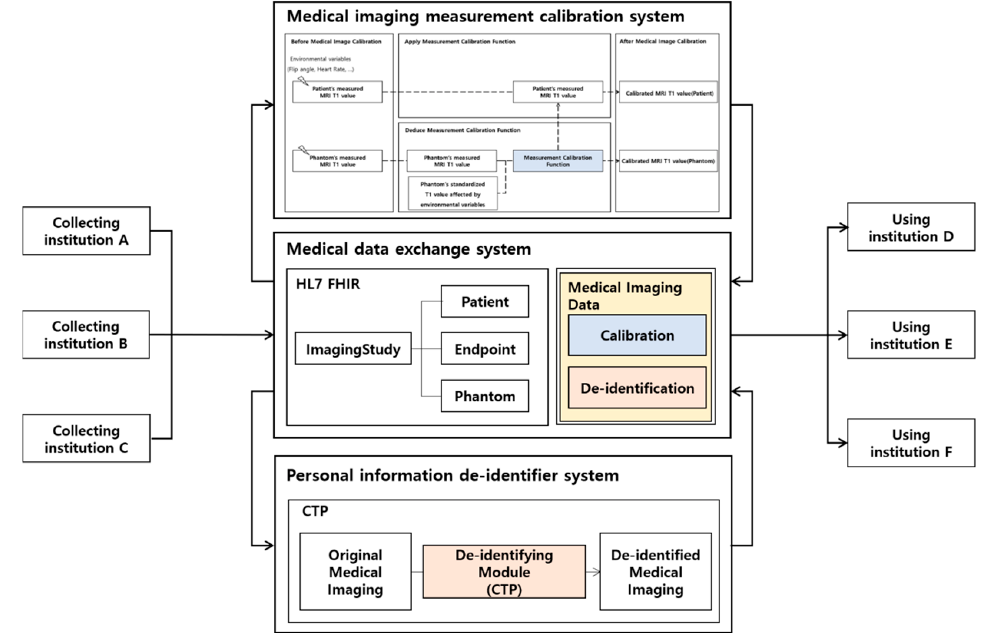
Figure 14. Medical Imaging Interoperability Reference Model.